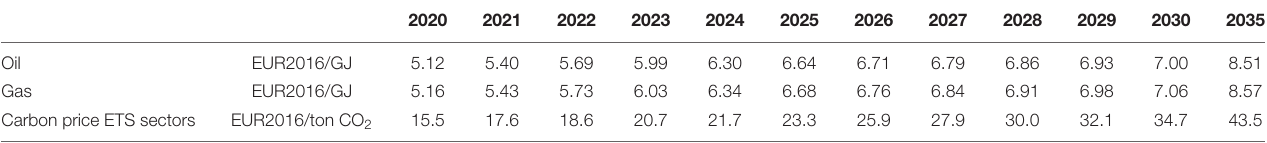
TABLE 1 | International Fuel prices assumed in the model.